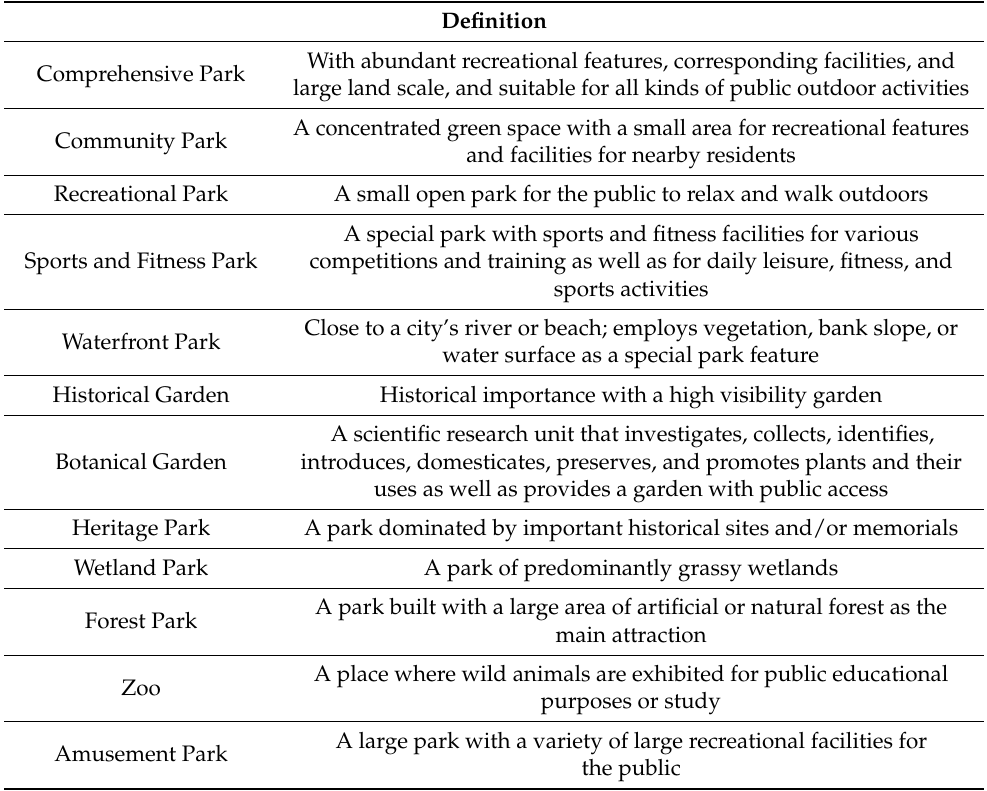
Table 1. Urban parks type